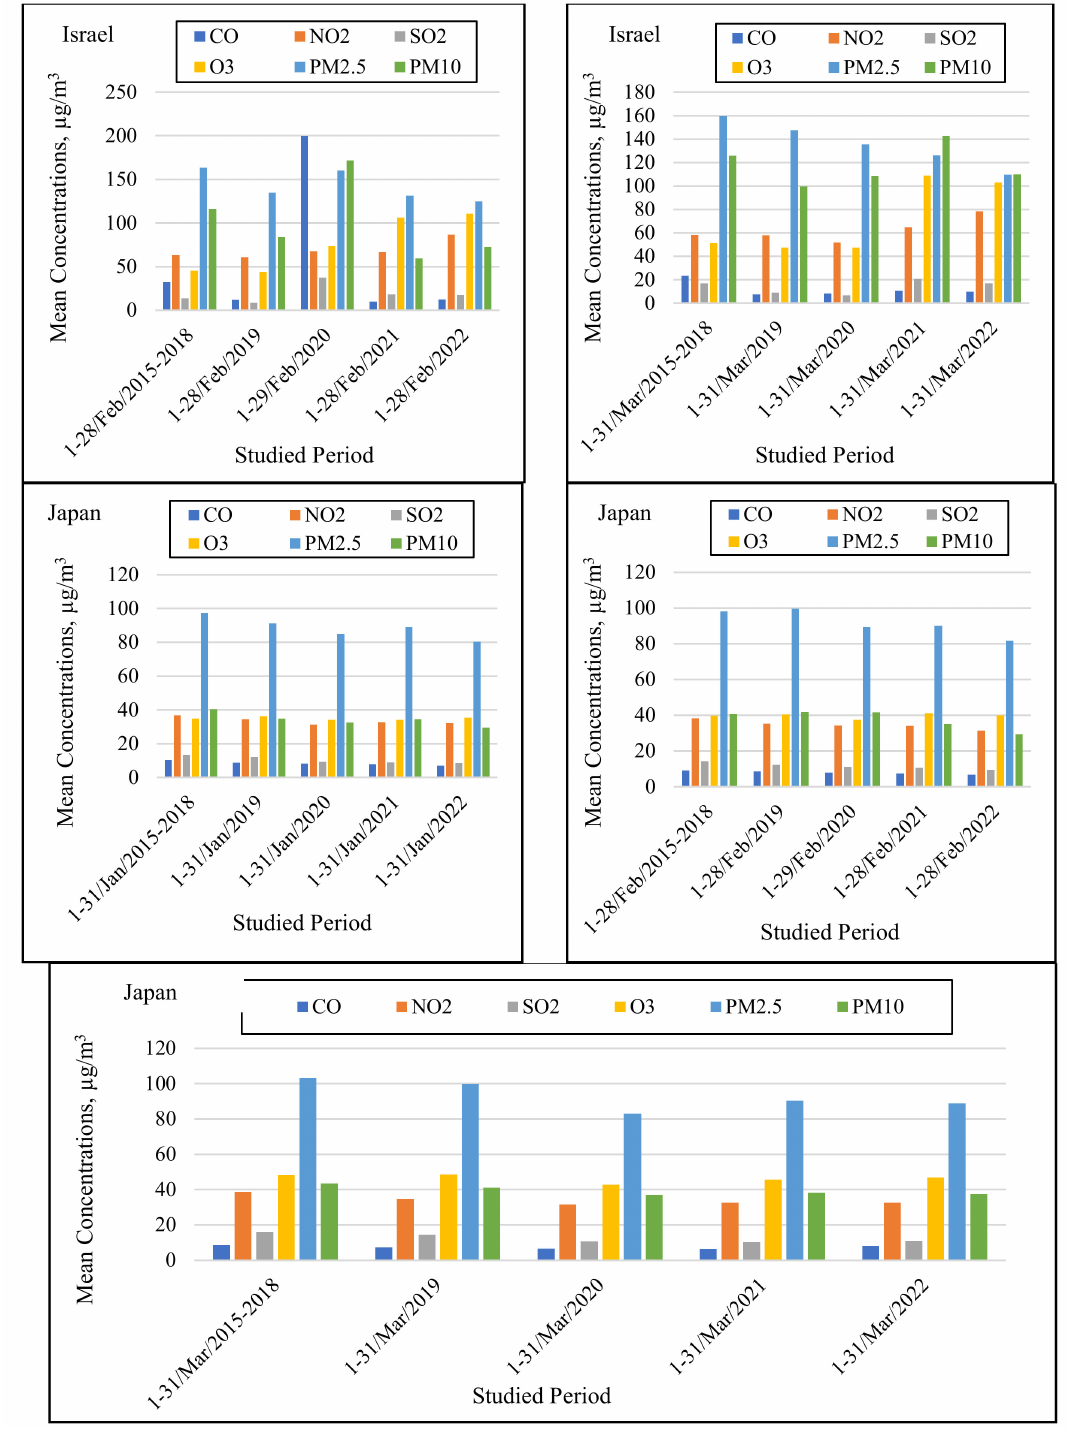
Figure 1. Average concentrations of air pollutant in countries of the Asian geoeconomic